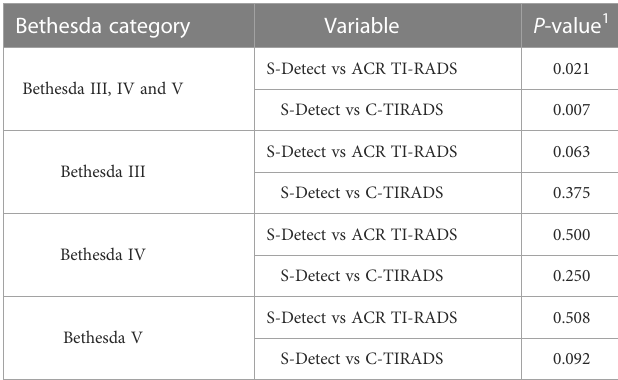
TABLE 6 Differences between S-Detect and the two TI-RADS classi fi